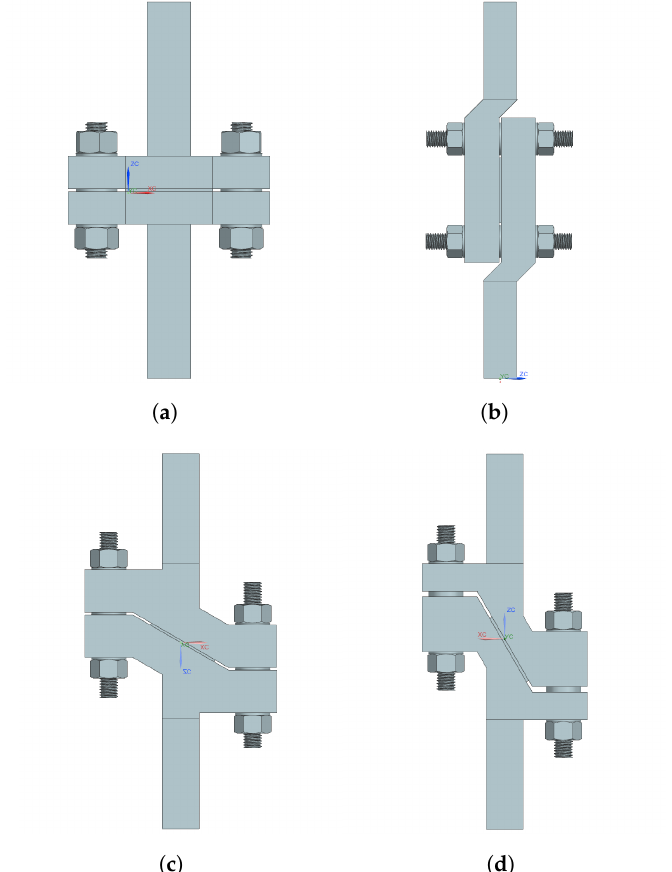
Figure 3. Four test tools are used for subjecting the sandwich specimens to LCs 1 and 3–5, presented in Figure 2. The test tool presented in ( a ) is used for transverse tensile loading, normal to the sandwich. In ( b ), the test tool used for loading the specimen in out–of–plane shearing is presented. In ( c , d ), the test tools for loading the sandwich 30 ◦ and 60 ◦ relative to the normal direction are presented.